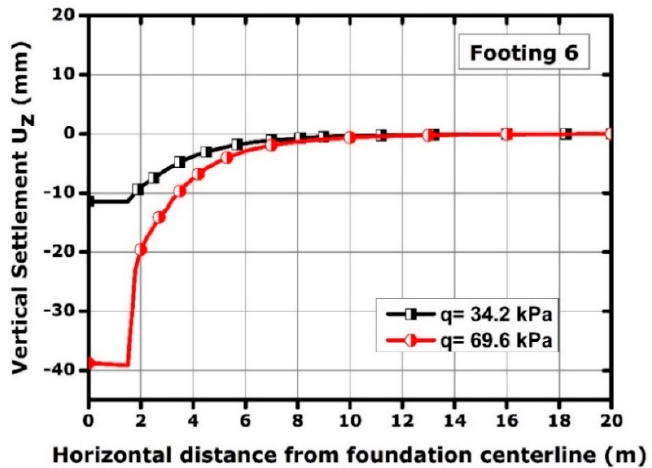
Figure 14. Influence of footing shape on the footing and ground surface settlement in drained conditions—Footing 6.